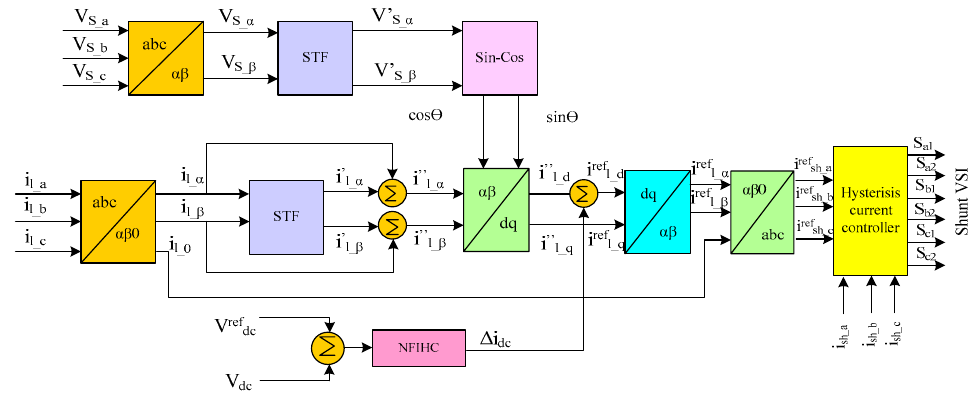
Figure 6. NFHC for Shunt Converter.